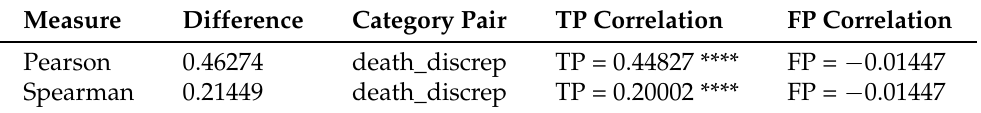
Table 44. Death and Discrepancy in All.